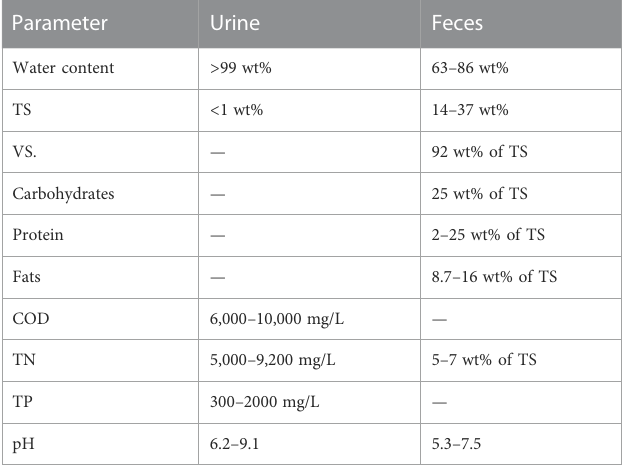
TABLE2Characteristics offeces foundintheliterature (source:LevittandDuane, 1972; Otterpohl, 2002; Penn et al., 2018; Rose et al.,